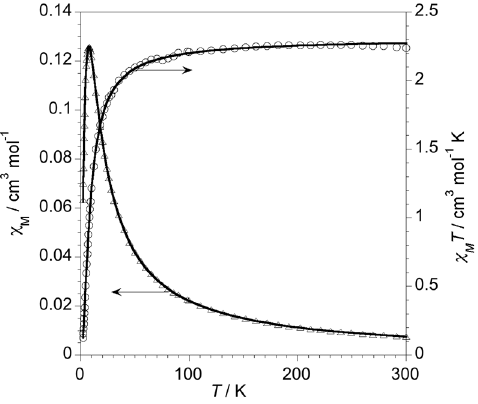
Figure 7. χ M T (o) and χ M ( ∆ ) against T plots for 4 . The solid lines are the best-fit curves through Equation (6) (see text).